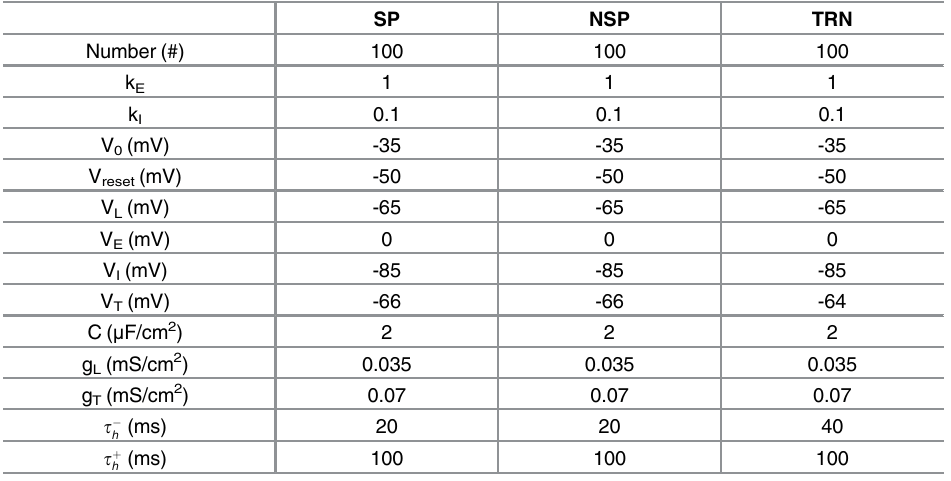
Table 2. Thalamic neuron parameter